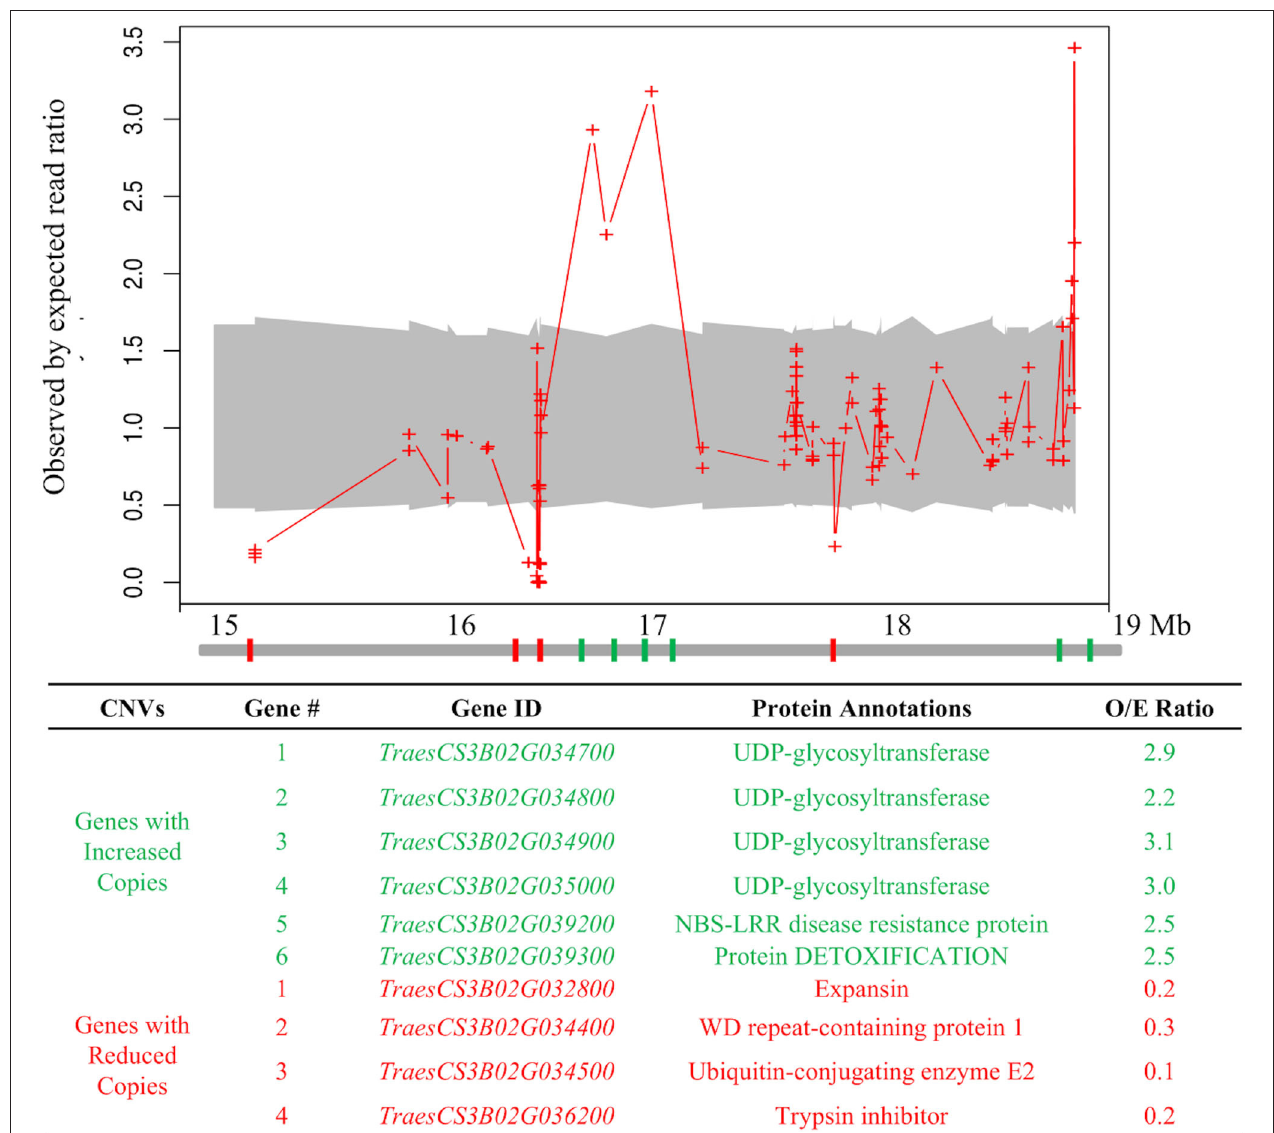
FIGURE 3 | Copy number variation at the Wsm2 locus in “Snowmass.” Values indicate the observed by expected read ratio between the “Snowmass” exome and a reference set of exomes from six other wheat varieties. The 95% confidence interval is marked by a gray shadow. Red crosses indicate a minimum number of ten reads mapped to this region. The diagram below indicates chromosome 3B from 15 Mbp to 19 Mbp. Genes highlighted in green are predicted to have more copies in “Snowmass,” whereas genes highlighted in red are predicted to have fewer copies in “Snowmass.” Gene number reflects their order from left to right in this diagram. The table describes the protein annotation observed by the expected read ratio (O/E ratio) averaged for all reads that mapped to each